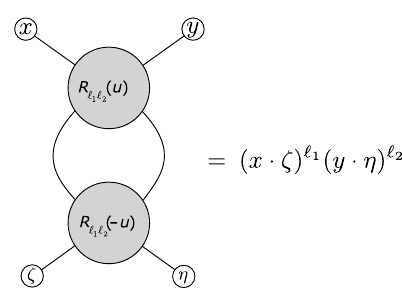
Figure 7 . Property (2.61) in the notation for the fused R l